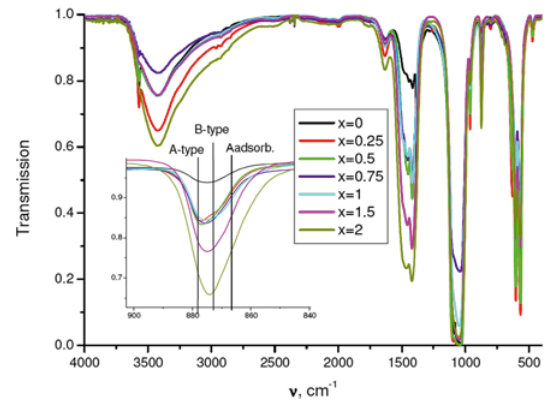
Figure 4. FTIR-spectra of